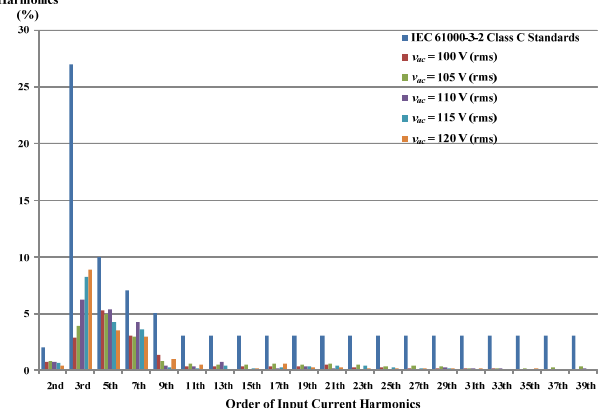
Figure 13. Measured input utility ‐ line voltage v AC (100 V/div) and current i AC (0.5 A/div); time scale: 5 ms/div.